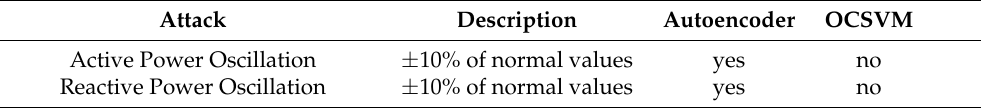
Table 4. Tests—Partial Attack.